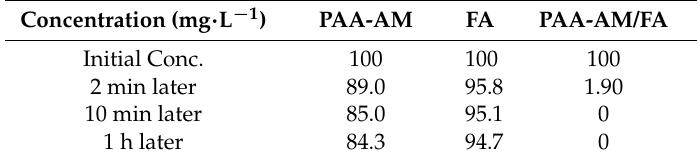
Table 8. The concentration of Rhodamine B after being processed with PAA-AM/FA in different time. Concentration (mg · L − 1 ) PAA-AM FA PAA-AM/FA Initial